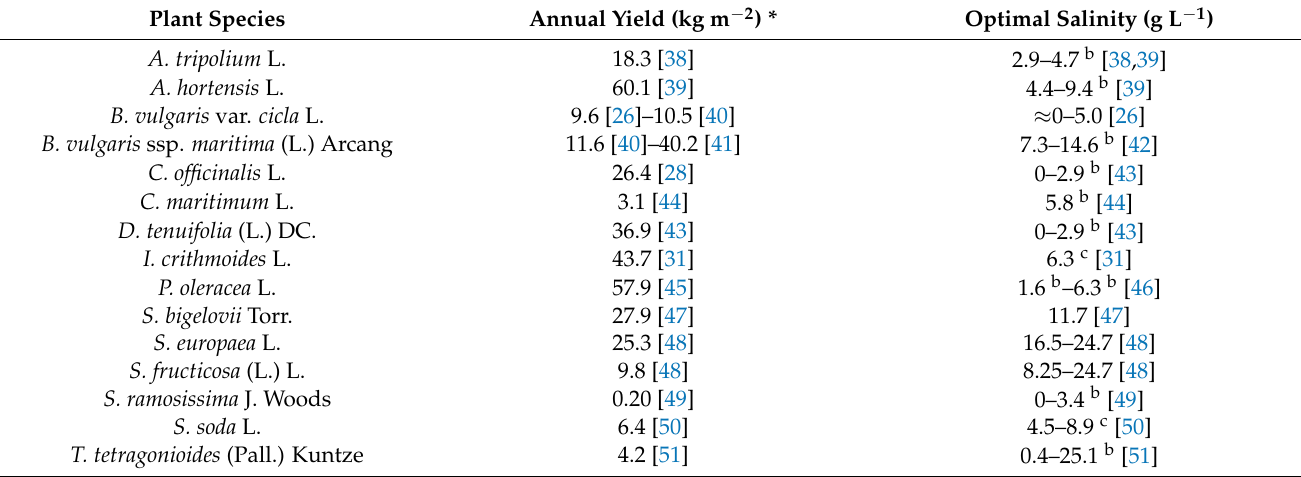
Table 3. Annual yield of the considered plant species under optimal growing conditions.